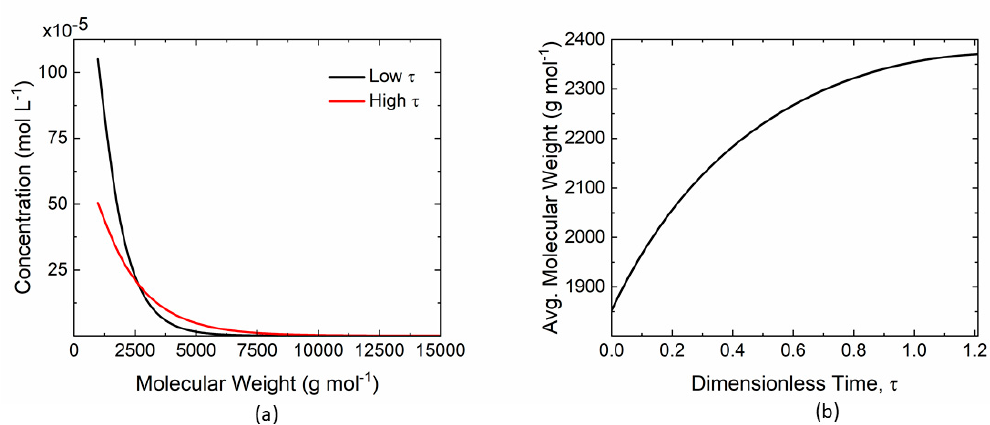
Figure 5. Evolution of the molecular weight of HKUST-1 MOF due to the aggregation of SBU oligomers at a constant frequency of attachment. ( a ) Concentration distribution of the molecular weight of MOF at low and high dimensionless times. ( b ) Transient evolution of the average molecular weight of MOFs.